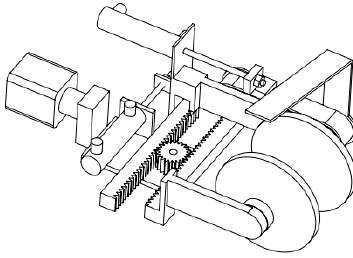
Figure 2. Schematic diagram of picking robot manipulator.